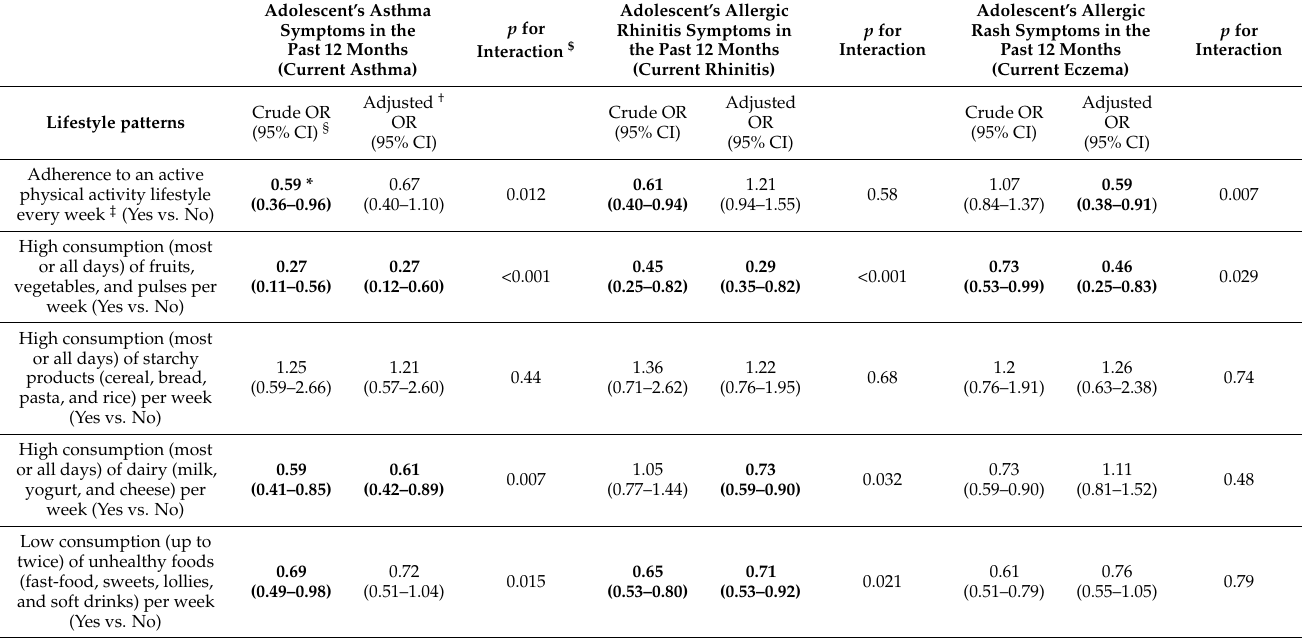
Table 3. Results from the multiple logistic regression analysis assessing the association between history of an atopic disease (asthma, rhinitis, eczema) in the past 12 months and adolescents’ lifestyle factors, adjusted for several confounders with the corresponding p -value derived from the log- likelihood ratio test of the multivariate model with and without the interaction term between each lifestyle pattern with parental educational level ( n = 1934).